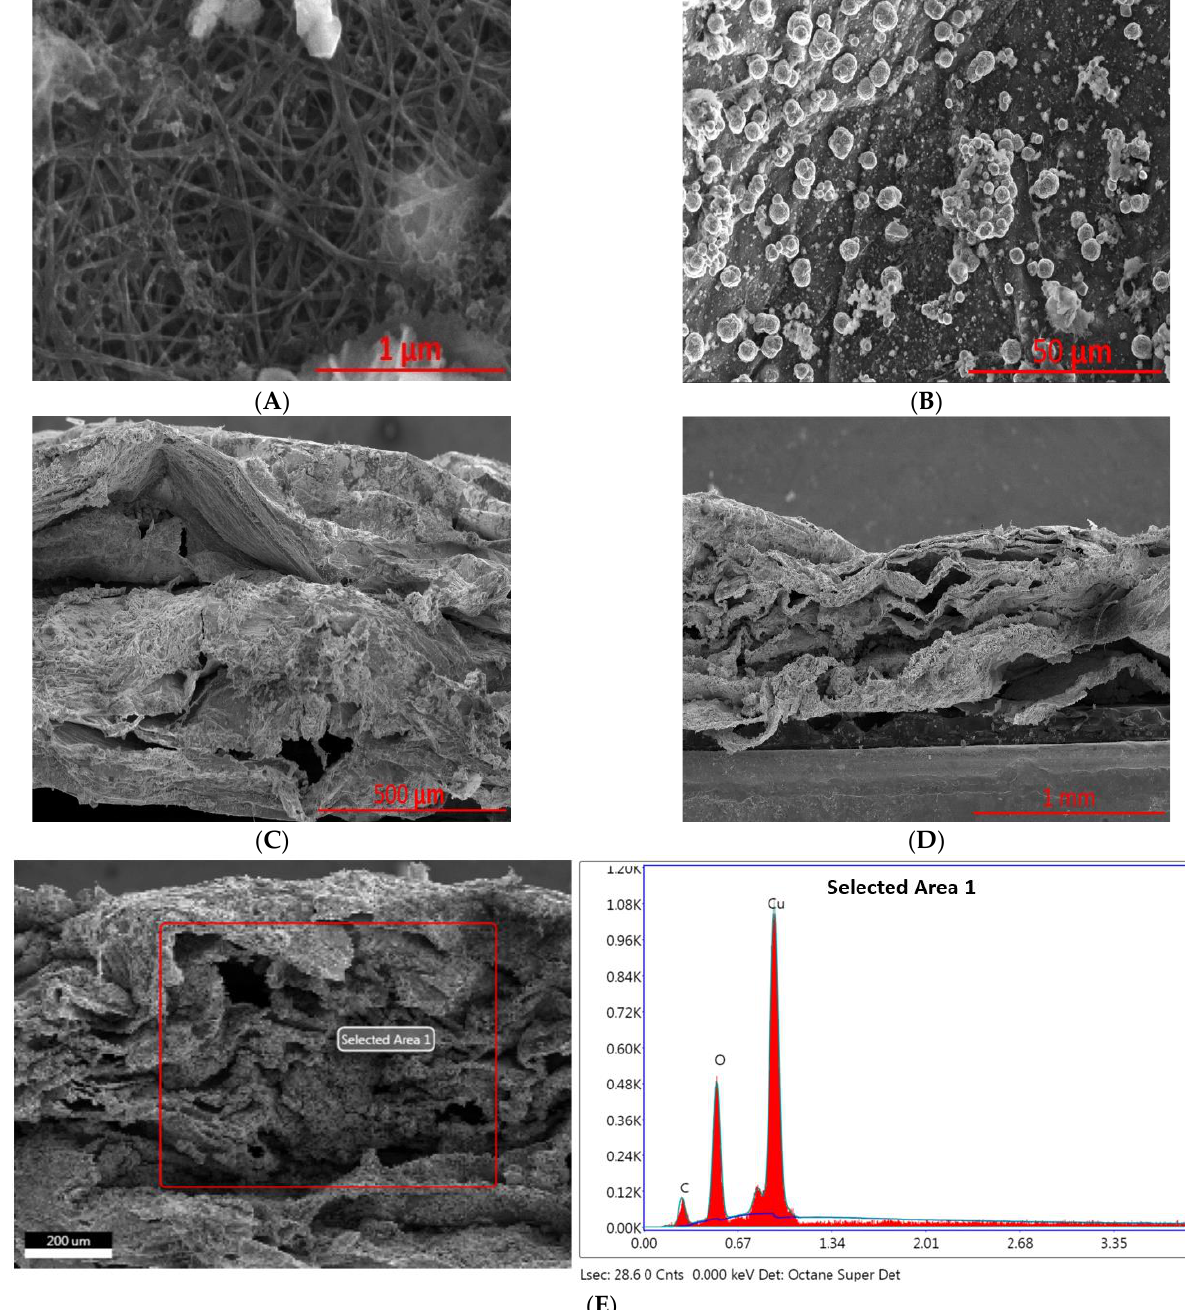
Figure 4. SEM images of activated CNT with Cu organic deposition: surface morphology ( A , B ), as well as cross-sectional images ( C , D ), and EDX spectrum from cross-sectional area of the activated sample ( E ).